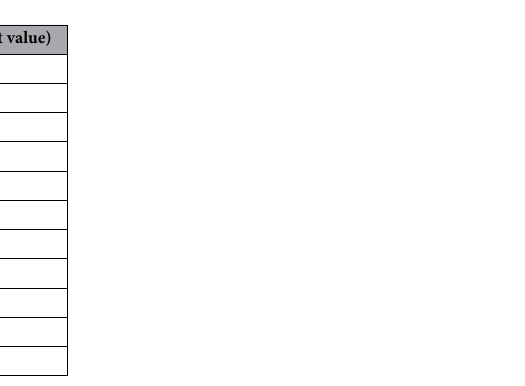
Figure 1. In silico analysis of the oligonucleotide alignment for the RT-LAMP assay included in the study. ( A ) Genetic map of the complete genome of SARS-CoV-2 Wuhan-Hu-1. ( B ) Alignment of the RT-LAMP designed oligonucleotides with the sequences of human coronaviruses: SARS-CoV-2 coronavirus, SARS coronavirus Tor2, MERS-related coronavirus, hCov OC43, hCov HKU1 and hCov 229E. NoD No detected, NTC Not template control, MM master mix.